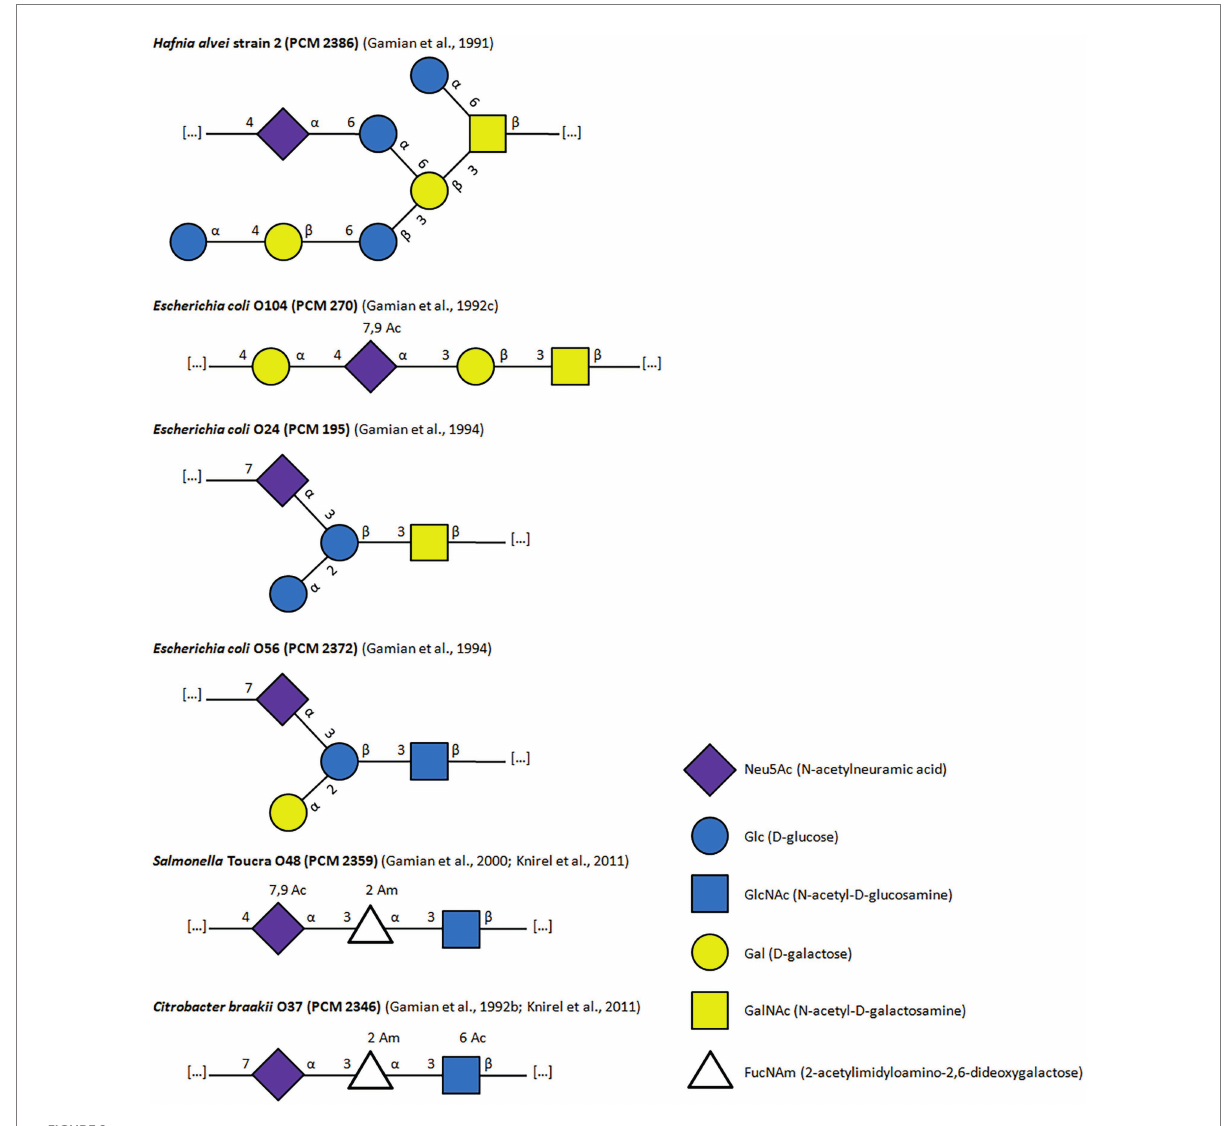
FIGURE 2 Structures of LPS containing Neu5Ac as a component of